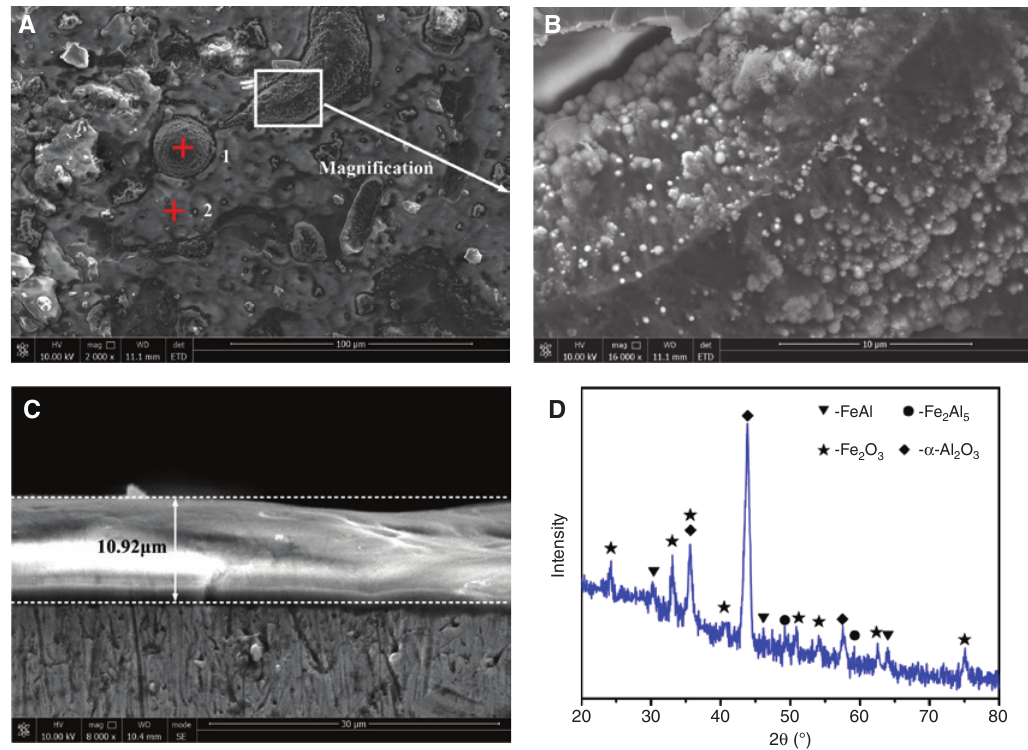
Figure 2: Morphology and phase of the plasma oxide coating (A) surface morphology, (B) the enlarged image of the boxed region in (A), (C) section morphology, (D) GAXRD pattern.